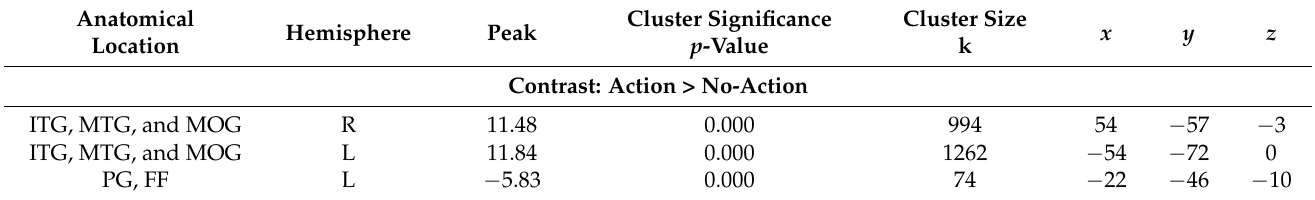
Table 1. Significant clusters of cue type main effect by contrasting action versus no-action cues.